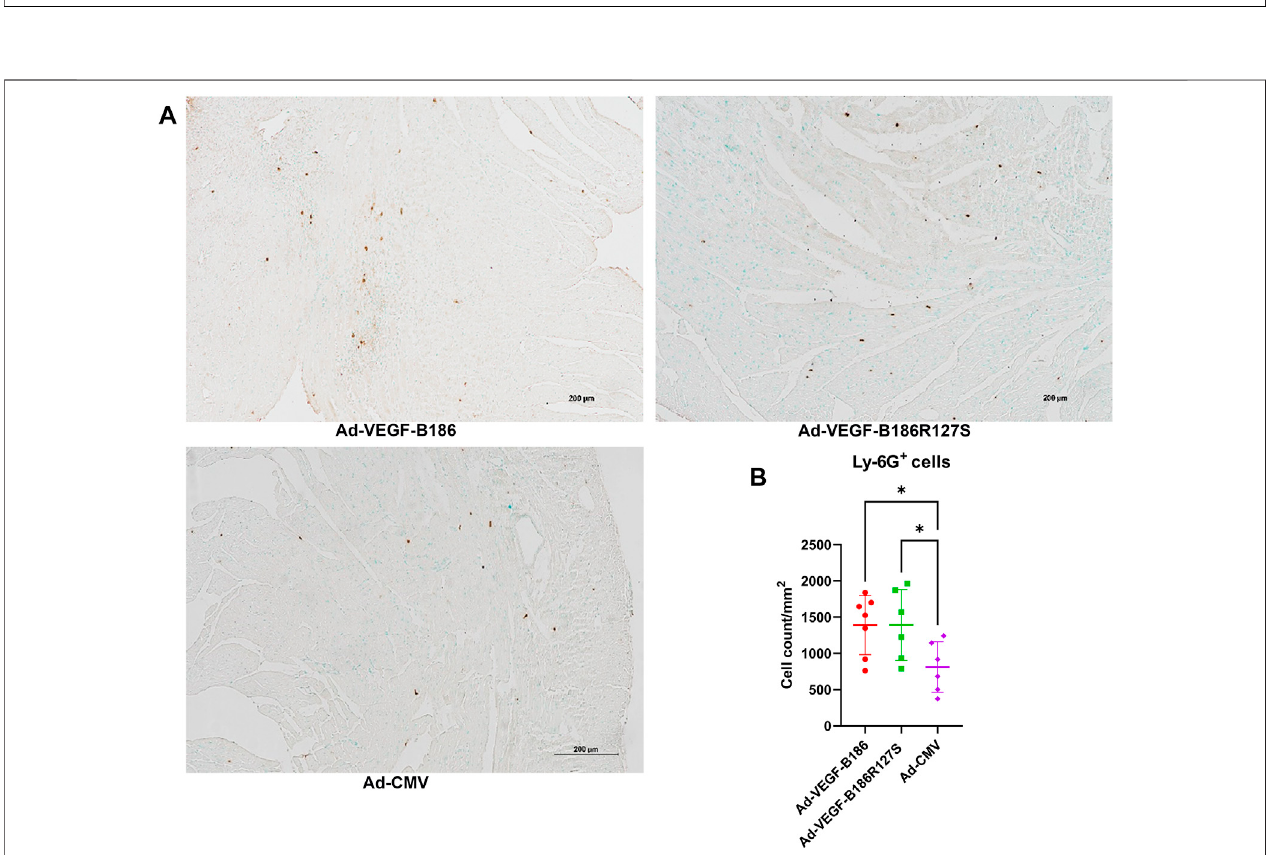
FIGURE 6 | Local accumulation of Ly6G + cells in murine heart. (A) Representative image of Ly6G + stained heart tissue sections. Scale bars, 200 μ m. ( B) Comparison of Ly6G + stained microvascular area in adenoviral vector injected regions of heart. Each dot indicates one mouse; n = 7 in Ad-VEGF-B186, n = 6 in Ad- VEGF-B186R127S, and n = 6 in Ad-CMV groups. Horizontal bars indicate mean ± SD and p values vs. each group by one-way ANOVA, followed by Dunnett ’ s multiple comparison test.